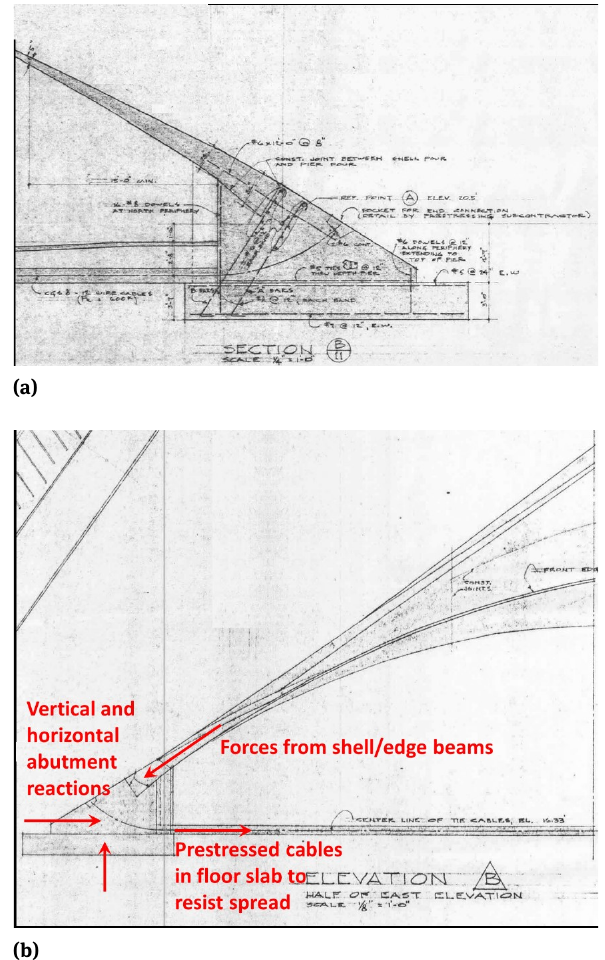
Figure 4: a) Buttressed support detail and b) abutment and slab reactions